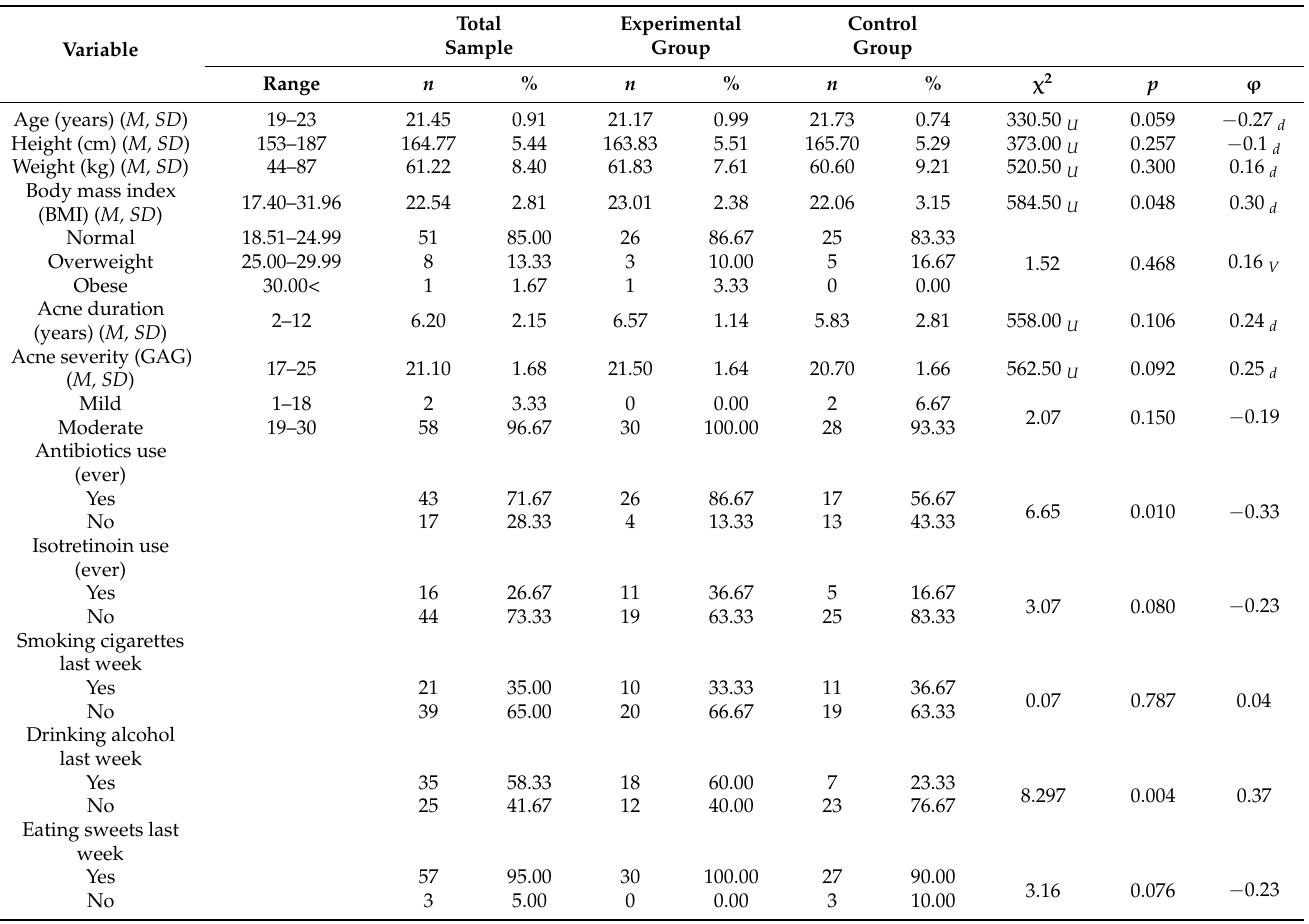
Table 1. Demographic characteristics of the